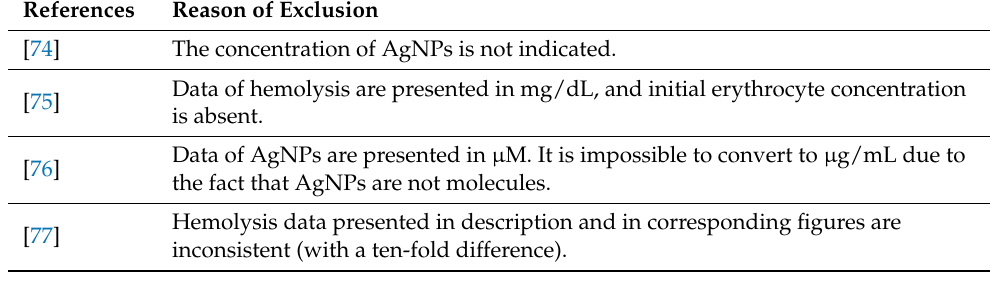
Table 1. Publications with data excluded from the meta-analysis.